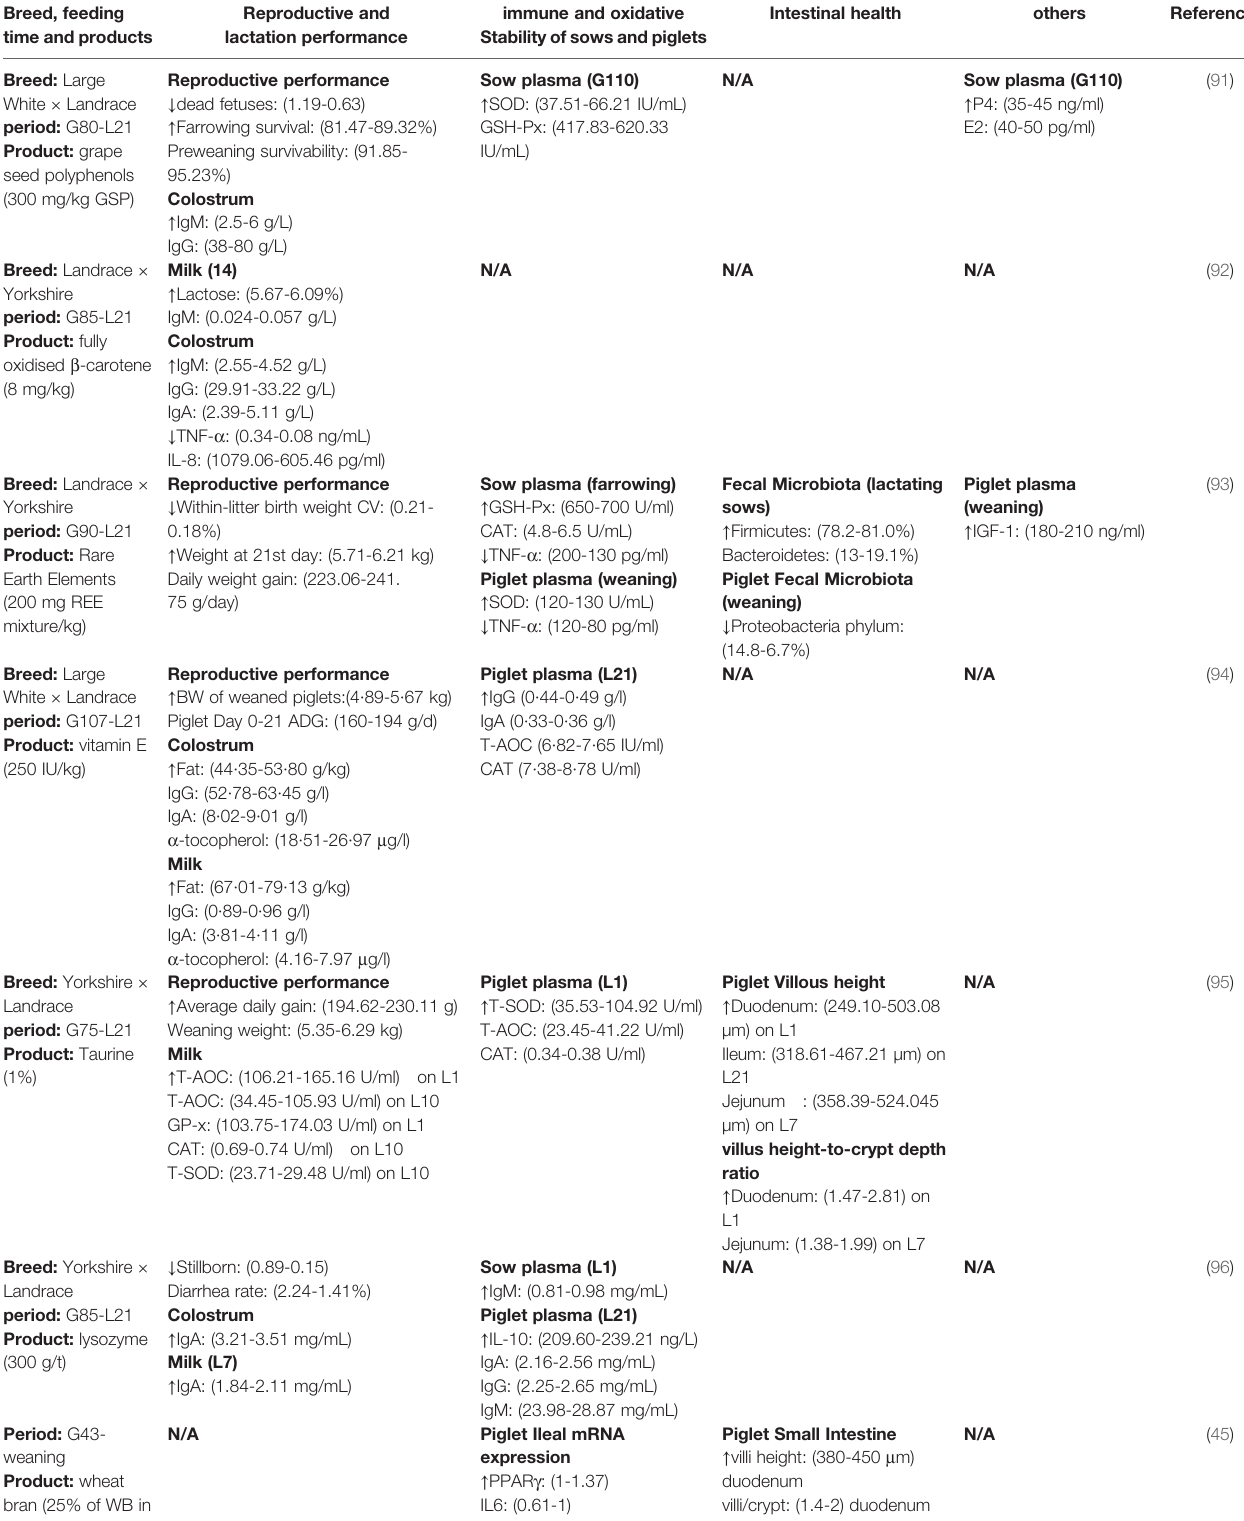
TABLE 3 | Maternal antioxidant and other substrates intake in the regulation of neonatal Infection, immunity and production performance. Breed, feeding Reproductive and immune and oxidative Intestinal health time and products lactation performance Stability of sows and piglets